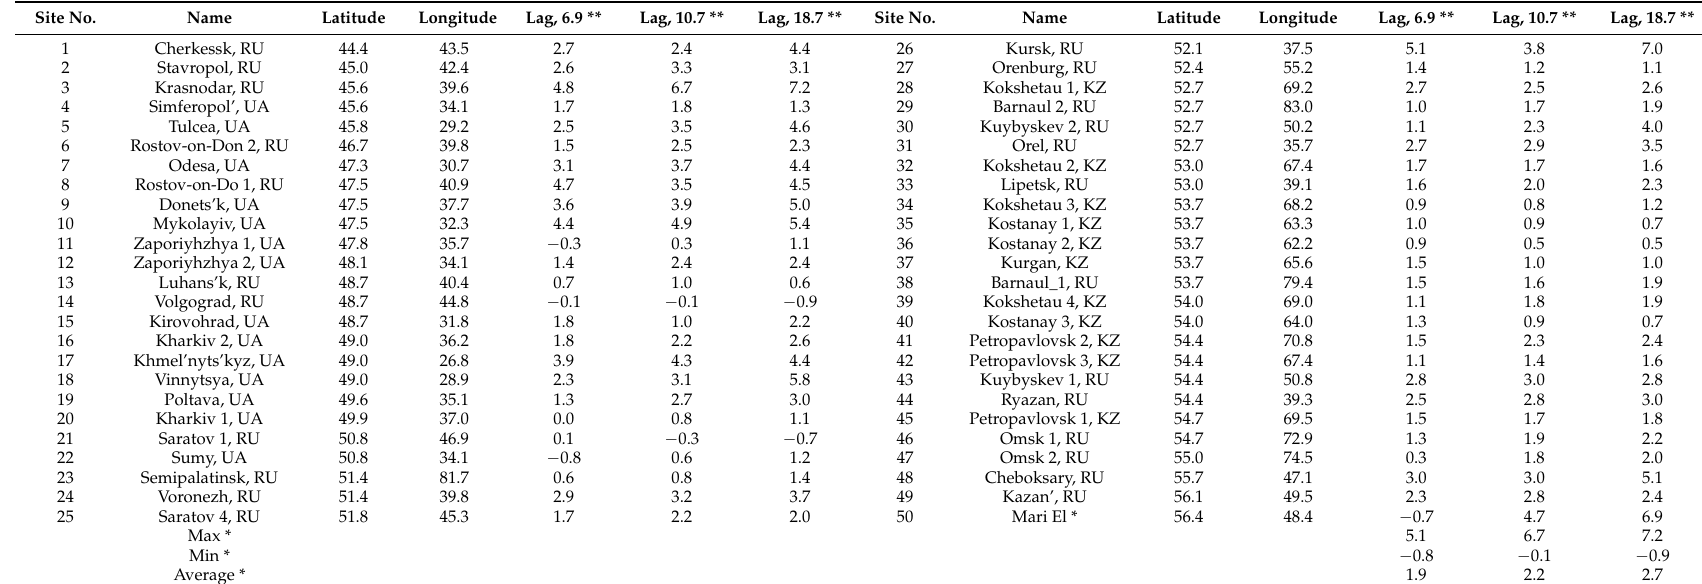
Table A1. Study sites average GDD, and PH VOD lags (in weeks) relative to PH NDVI (Figure